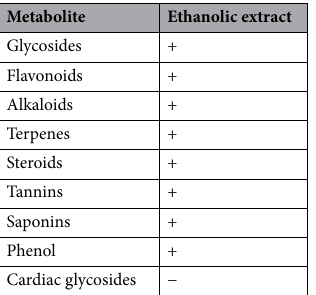
Table 1. Phytochemical analysis of the crude extract of Hypoxis